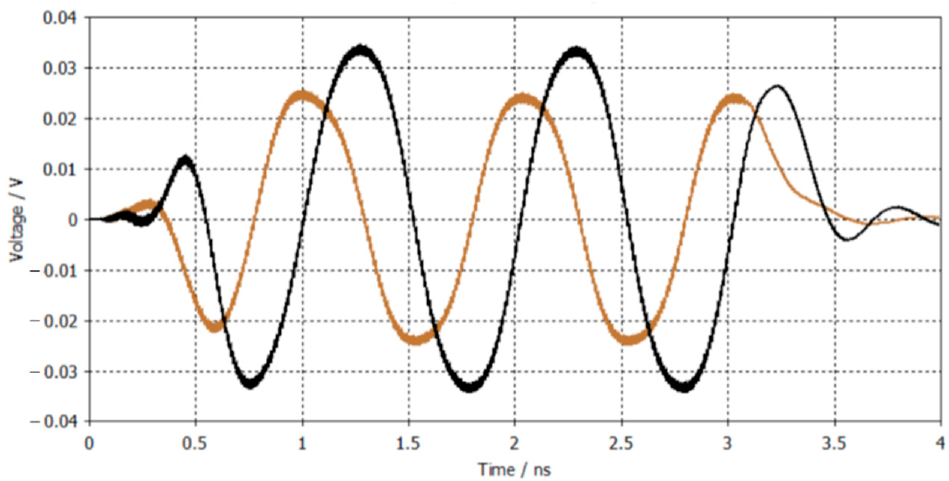
Figure 8. Simulated signals at the I and Q outputs of the designed quadrature mixer.